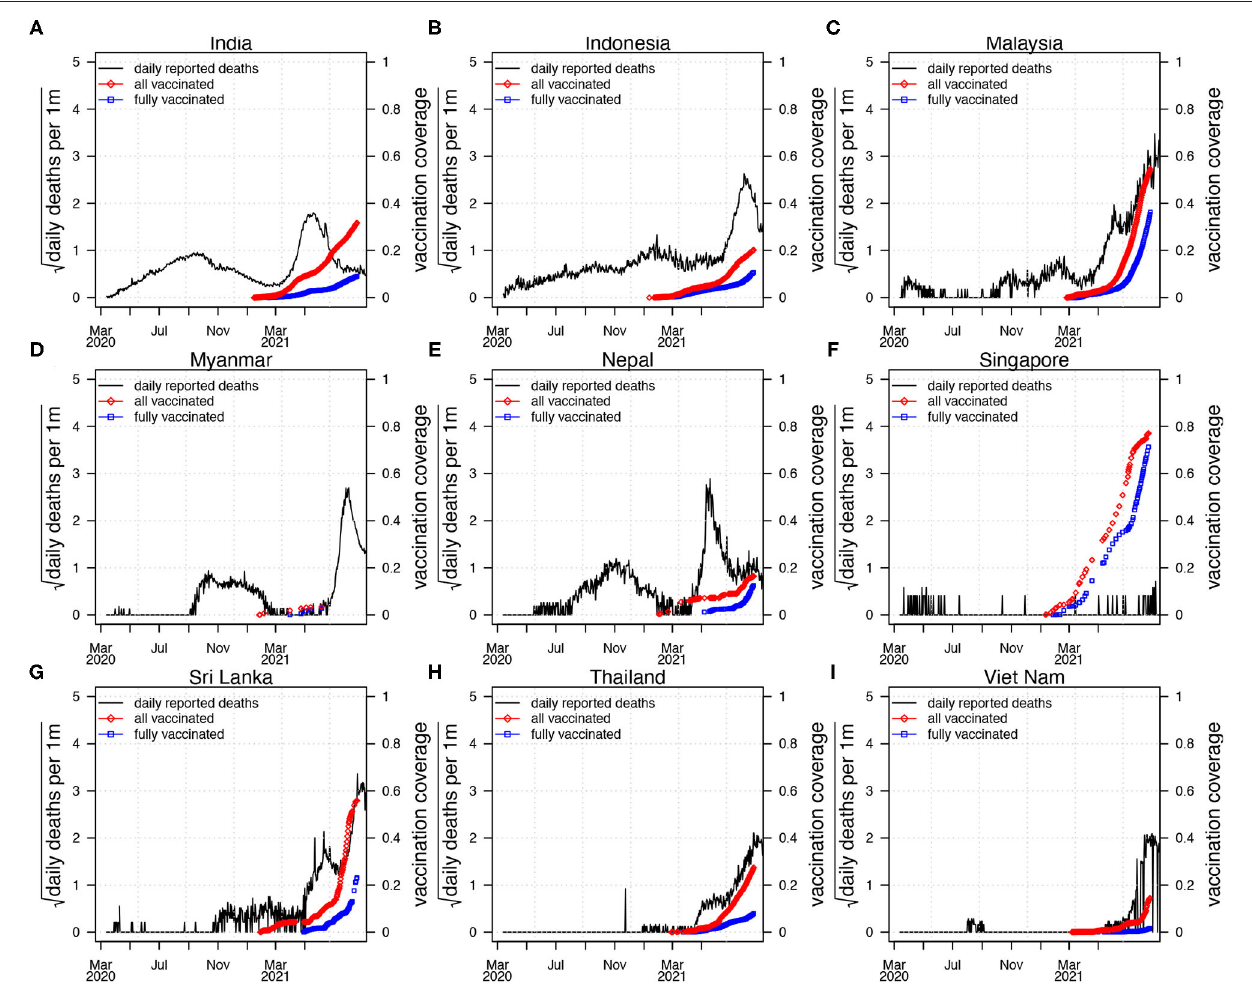
FIGURE 1 | Reported confirmed coronavirus disease 2019 (COVID-19) deaths (black curve) in nine countries in SEA and SA, with vaccination coverage. All the vaccinated proportion (red diamond, vaccinated/one plus dose) and fully vaccinated proportion of the population (blue square, fully vaccinated). The first wave of COVID-19 epidemic occurred largely before March 2021, and the second wave of COVID-19 epidemic appeared after March 2021. (A) India, (B) Indonesia, (C) Malaysia, (D) Myanmar, (E) Nepal, (F) Singapore, (G) Sri Lanka, (H) Thailand, (I) Viet